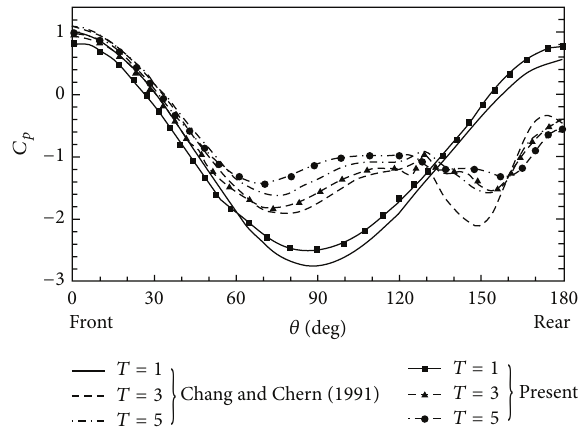
Figure 9: Surface pressure distribution at several instants for Re = 3000 compared with numerical results of Chang and Chern (1991)